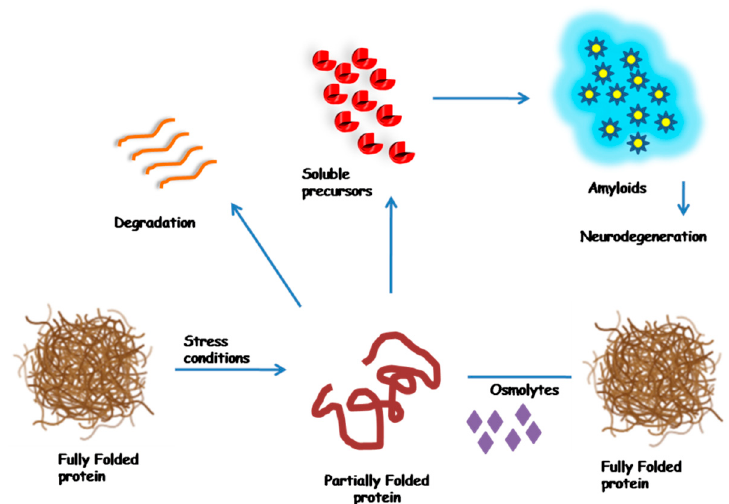
Figure 2. A probable curative mechanism for using osmolytes to prevent misfolded/aggregation. Under stress conditions, the structure of a fully folded protein is compromised due to inadequate folding of protein that may result either in discarded degradation or into the development of soluble precursors to facilitate amyloid formation. Osmolytes can assist in converting partially folded protein back into fully folded protein, thereby restoring proper functions of proteins, leading to the prevention of disease.